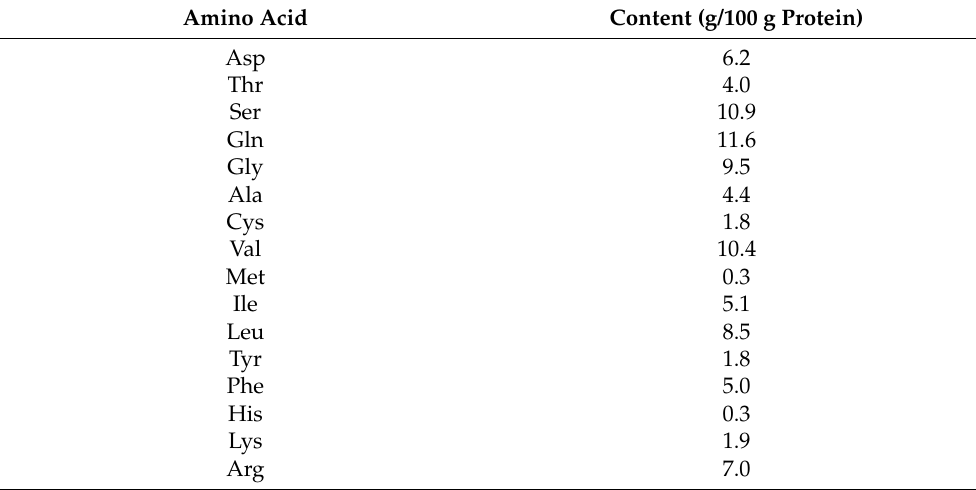
Table 2. Amino acid composition of keratin